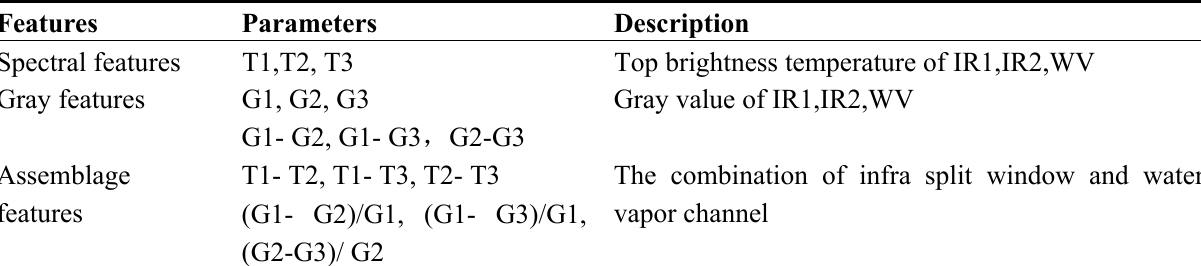
Table 3. Selected Features according to the Gray Level Co-occurrence Matrices (GLCM) for cloud classification. Note that Ti (T1, T2, T3) is the Tbb of channel i (IR1, IR2 and WV) and Gi (G1, G2, G3) is the gray value of channel i (IR1, IR2 and WV).